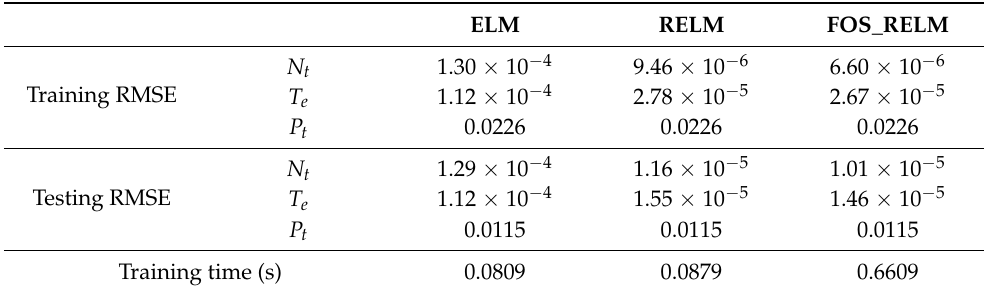
Table 2. Model identification effects of ELM, RELM, and FOS_RELM algorithms.